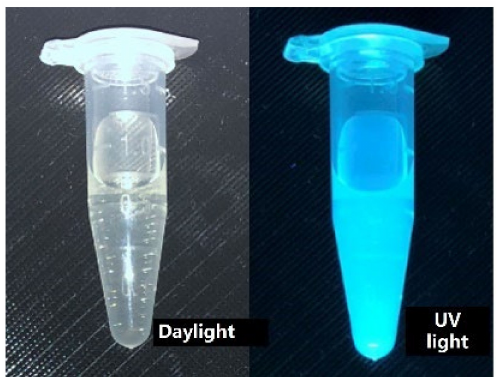
Figure 8. Photographs of the CQDs in daylight and UV light (365 nm).